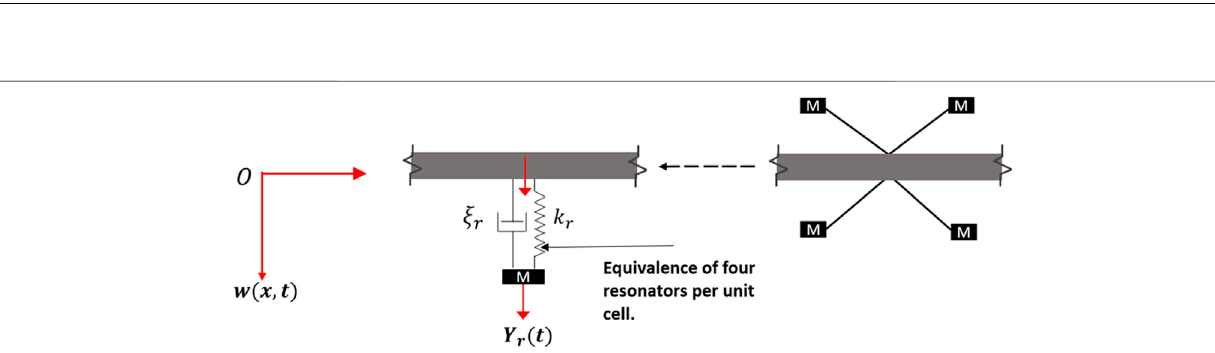
relative velocities of the beams as shown in Figure 2 . The free body diagram of the local resonators within a unit cell is shown in Figure 3 . An approximate model of the transmissibility of the